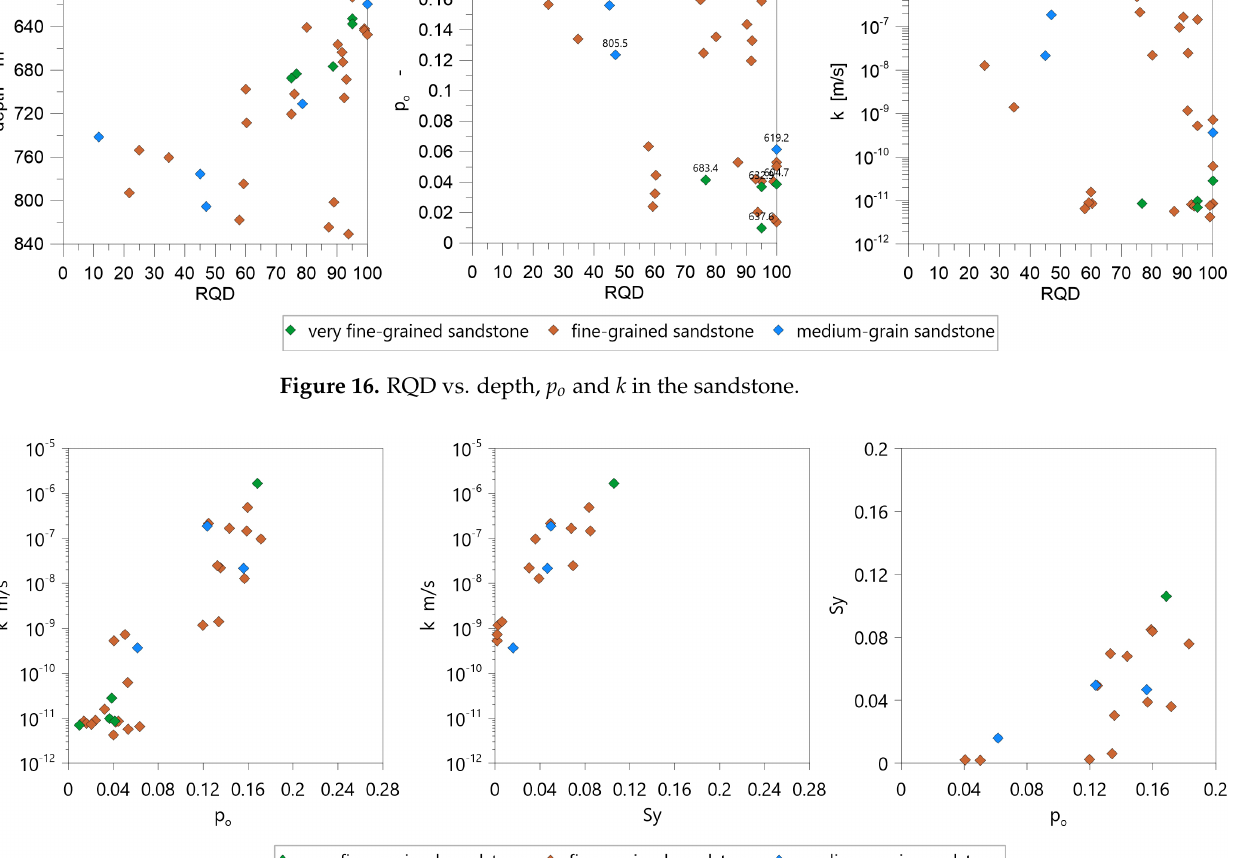
Figure 17. k vs. p o and S y , p o vs. S y